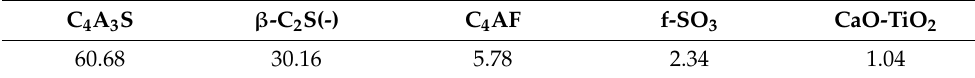
Table 3. The mix proportions for the cementitious